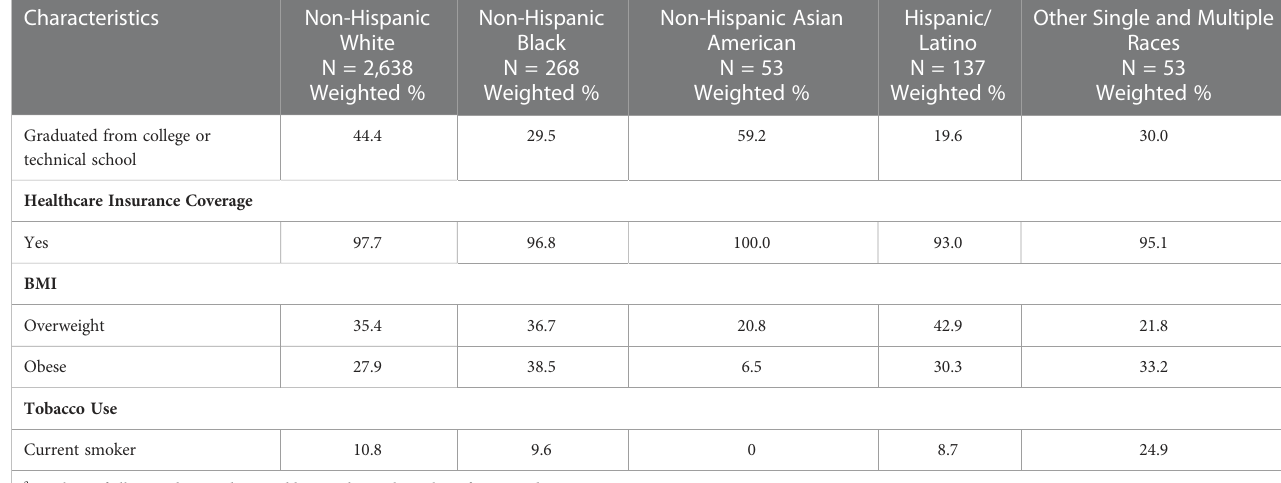
TABLE 2 Results of Multivariable Analyses Predicting Prevalence of Diabetes among Cancer Patients by Racial and Ethnic Category, 2021 NHIS a .